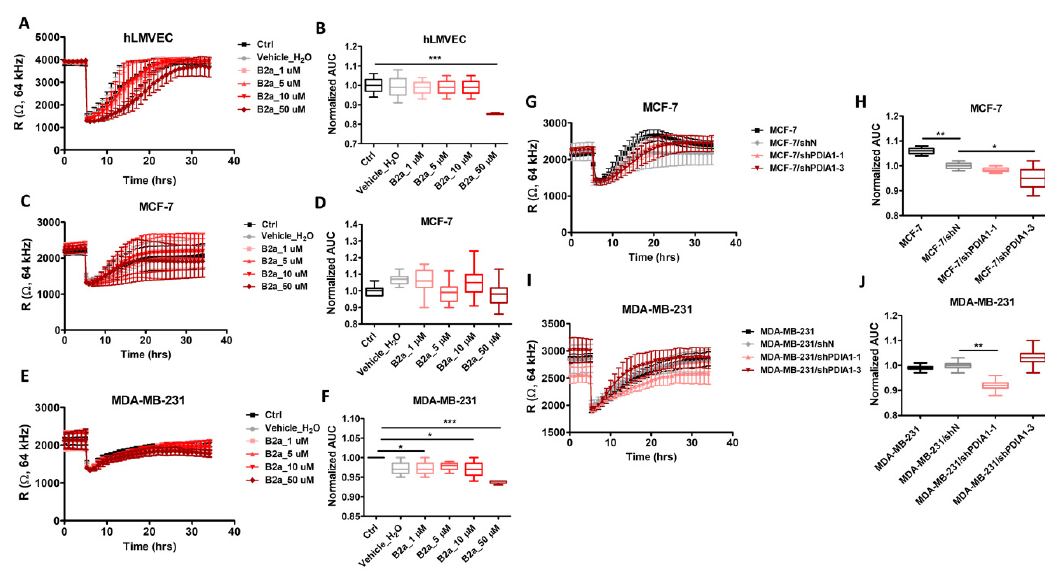
Figure 2. E ff ects of PDIA1 inhibition on wound-healing and migration of breast cancer cells and endothelial cells. ECIS Wound-Healing Assay of hLMVEC, MCF-7 and MDA-MB-231 cells and breast cancer sublines with silencing of PDIA1 (shN, shPDIA1-1 and shPDIA1-3). Real time tracings in hLMVECs ( A ), MCF-7 ( C ) and MDA-MB-231 ( E ) cell lines after addition of bepristat 2a at various concentrations (1, 10, 30 or 50 µ M) and after PDIA1 silencing in MCF-7 ( G ) and MDA-MB-231 ( I ) cell lines. Area under the curve boxplots represent AUC quantitation of changes in migration rate of bepristat 2a-treated hLMVECs ( B ), MCF-7 ( D ) and MDA-MB-231 ( F ) cell lines versus non-treated controls as well as MCF-7 ( H ) or MDA-MB-231 ( J ) sublines transduced against PDIA1 (shPDIA1-1, shPDIA1-3) or wild type cells regarding to negative sequence (shN). The line graphs and AUC boxplots represent mean ± SD of three independent experiments. Statistical analysis was calculated using parametric one-way ANOVA followed by Dunnett's multiple comparisons test (* p = 0.05, ** p = 0.01, *** p = 0.001).